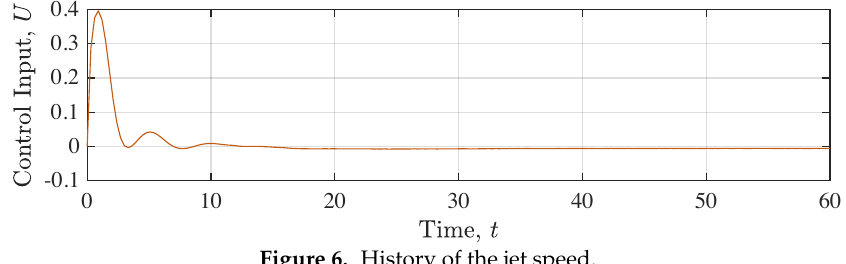
Figure 6. History of the jet